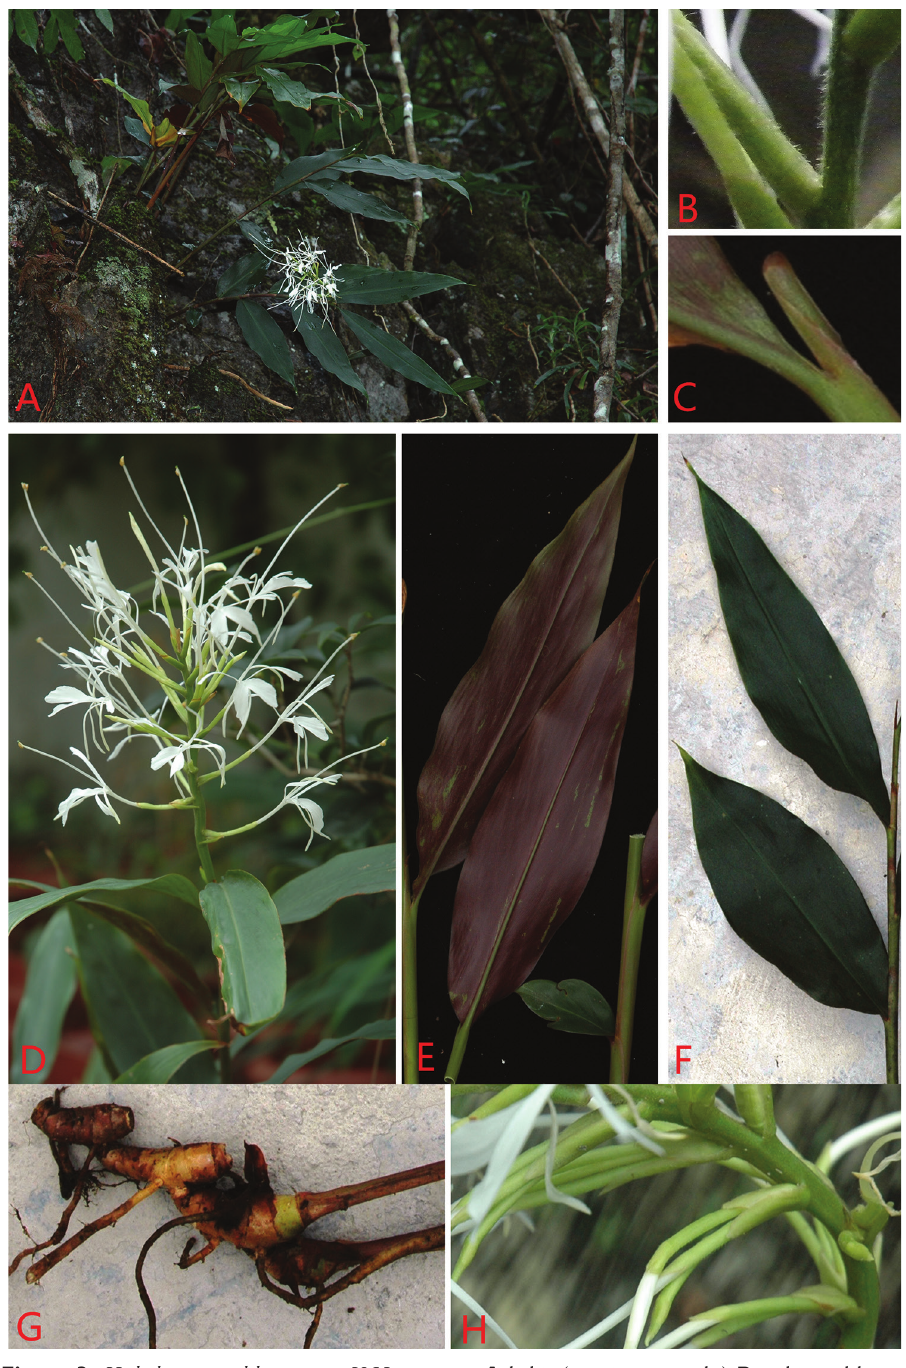
Figure 3. Hedychium viridibracteatum X.Hu sp. nov. A habit (growing on rocks) B rachis and bracts (pubescent) C ligule (glabrous) D inflorescence at anthesis E leaf blade surface (adaxial view) F leaf blade surface (abaxial view) G rhizome H portions of inflorescence (2–4 flowers per